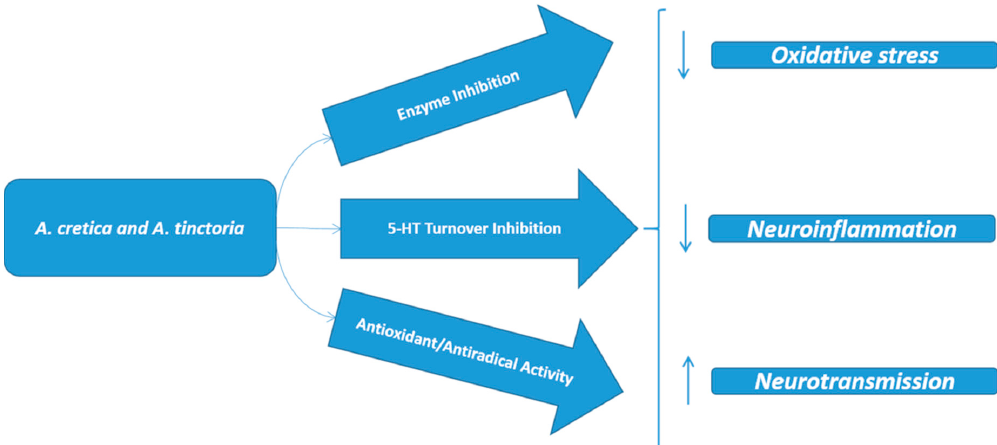
Figure 8. Protective e ff ects induced by A. cretica and A. tinctoria extracts, as evidenced by the present pharmacological investigation.